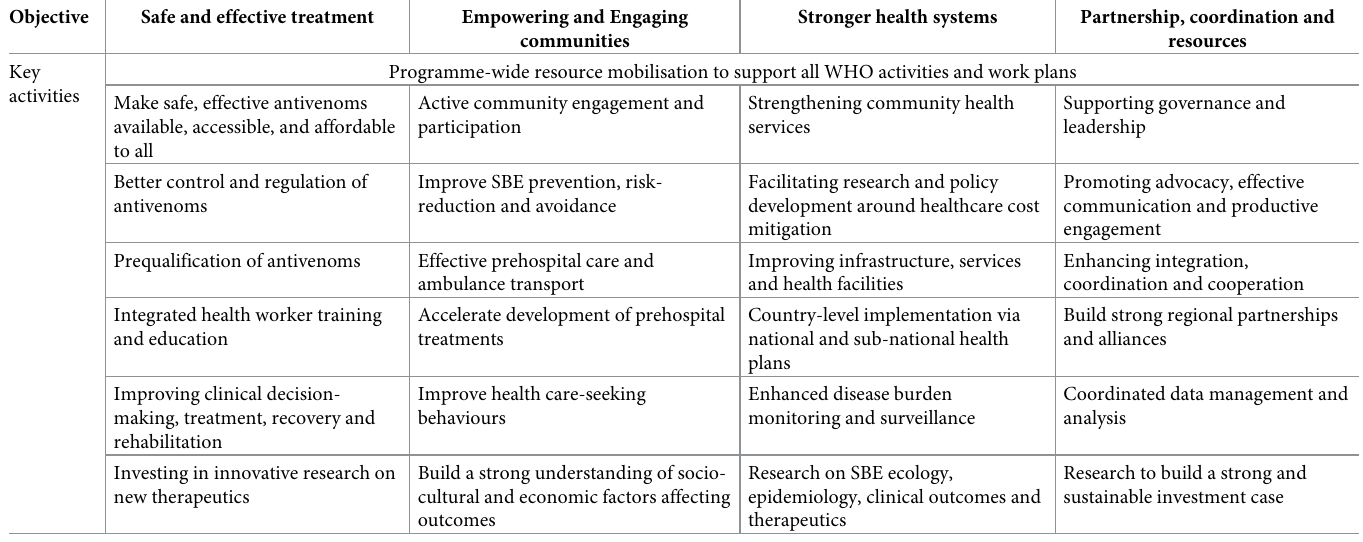
Table 1. Summary of overall program